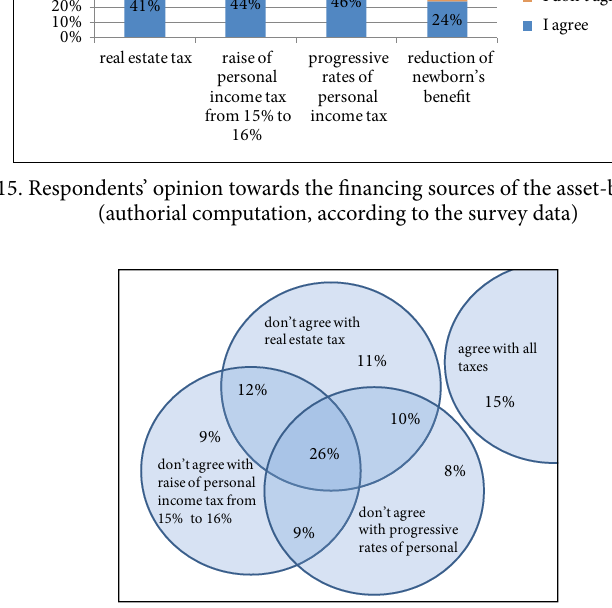
Fig. 16. Respondents’ separation to sets, regarding approval/disapproval to financing sources for the asset-based policy (authorial computation, according to the survey